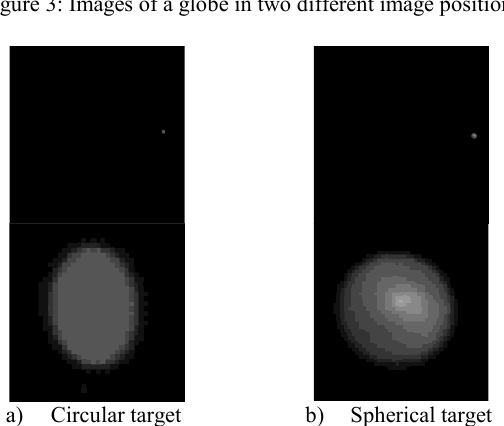
Figure 4: Images of circular and spherical targets at similar image positions (top: original image; bottom: enlarged